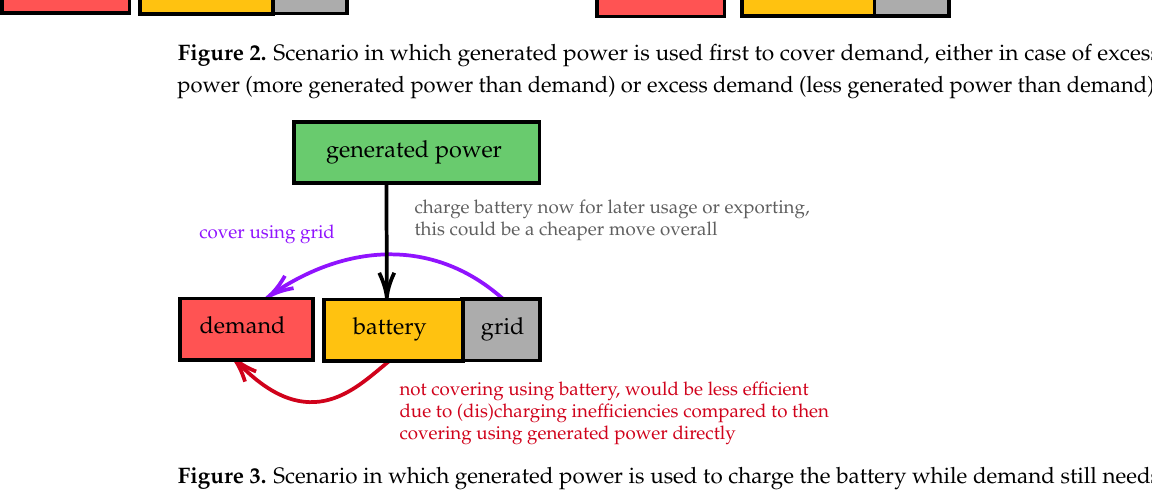
Figure 3. Scenario in which generated power is used to charge the battery while demand still needs to be